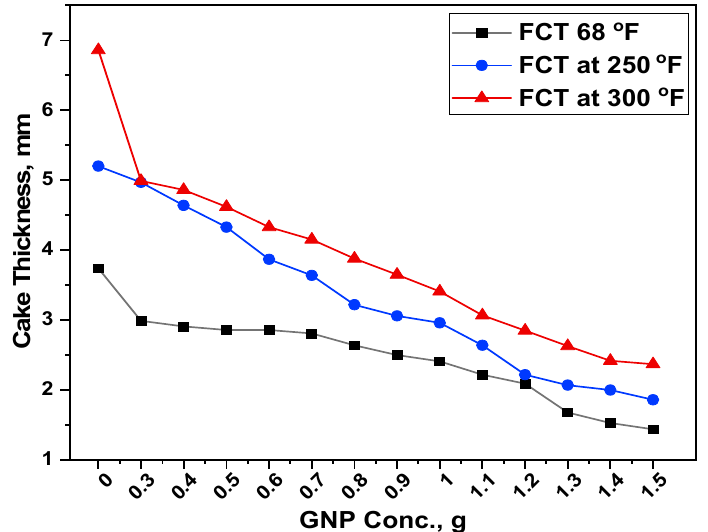
Figure 8. Filtercake thickness of the formulated muds at ambient and high temperatures.